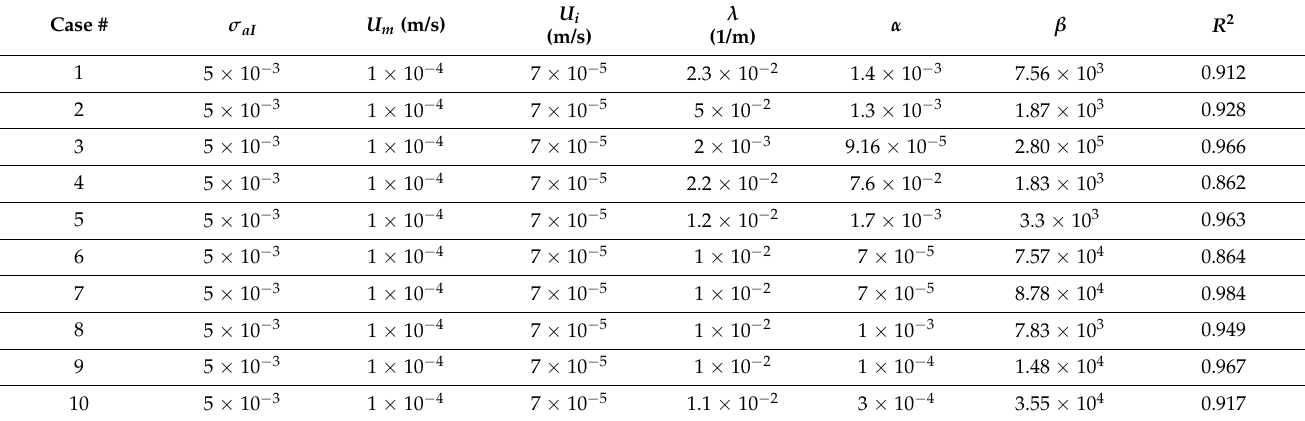
Table 4. Tuned and assumed values for fines-migration formation-damage model